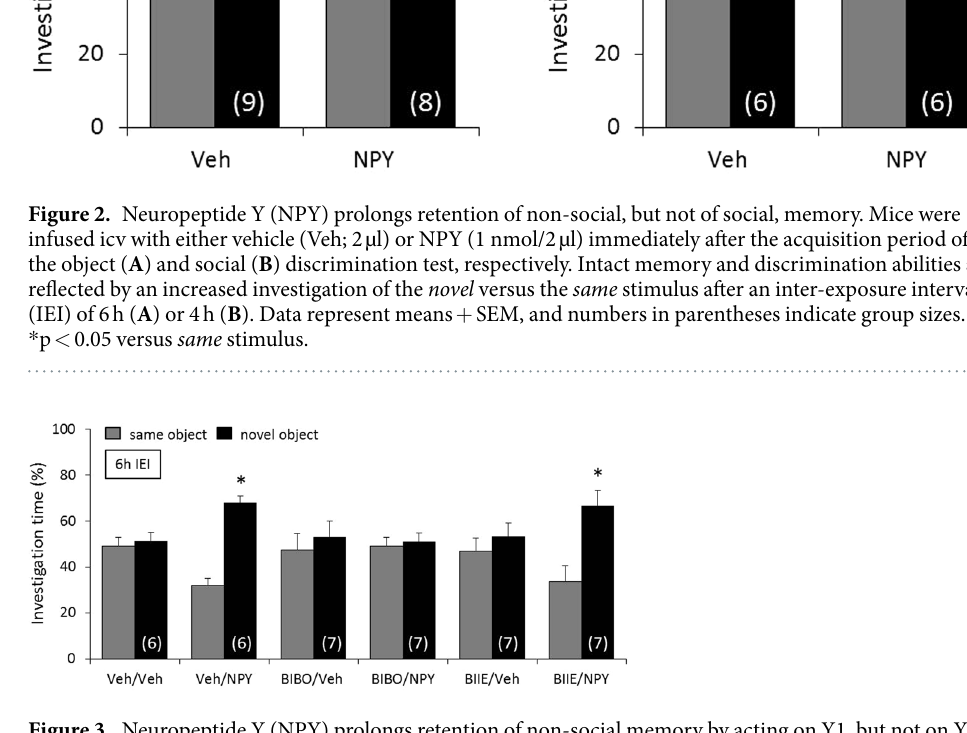
Figure 3. Neuropeptide Y (NPY) prolongs retention of non-social memory by acting on Y1, but not on Y2, receptors. Mice were infused icv with either vehicle (Veh; 2 µ l), BIBO (2 nmol/2 µ l), or BIIE (2 nmol/2 µ l) immediately after the acquisition period of the object discrimination test. After 10 min, mice were infused again with either Veh (2 µ l) or NPY (1 nmol/2 µ l). Intact memory and discrimination abilities are reflected by an increased investigation of the novel versus the same object after an inter-exposure interval (IEI) of 6 h. Data represent means + SEM, and numbers in parentheses indicate group sizes. * p < 0.05 versus same object.